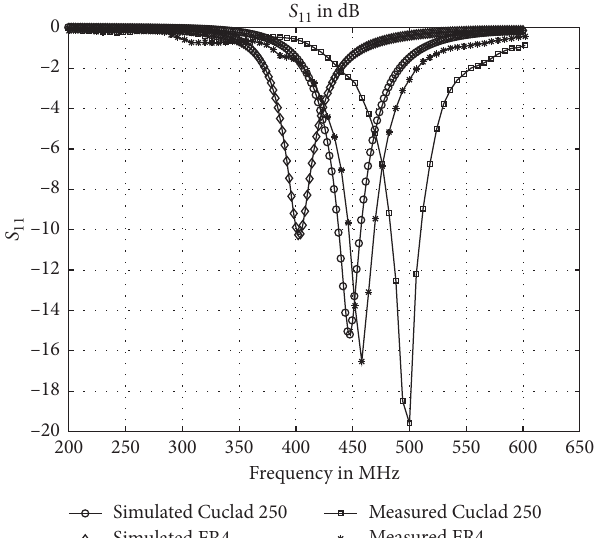
Figure 5: Comparison of reflection coefficient S 11 obtained through simulations and measurements vs frequency for the designed antenna using two different materials as substrates.